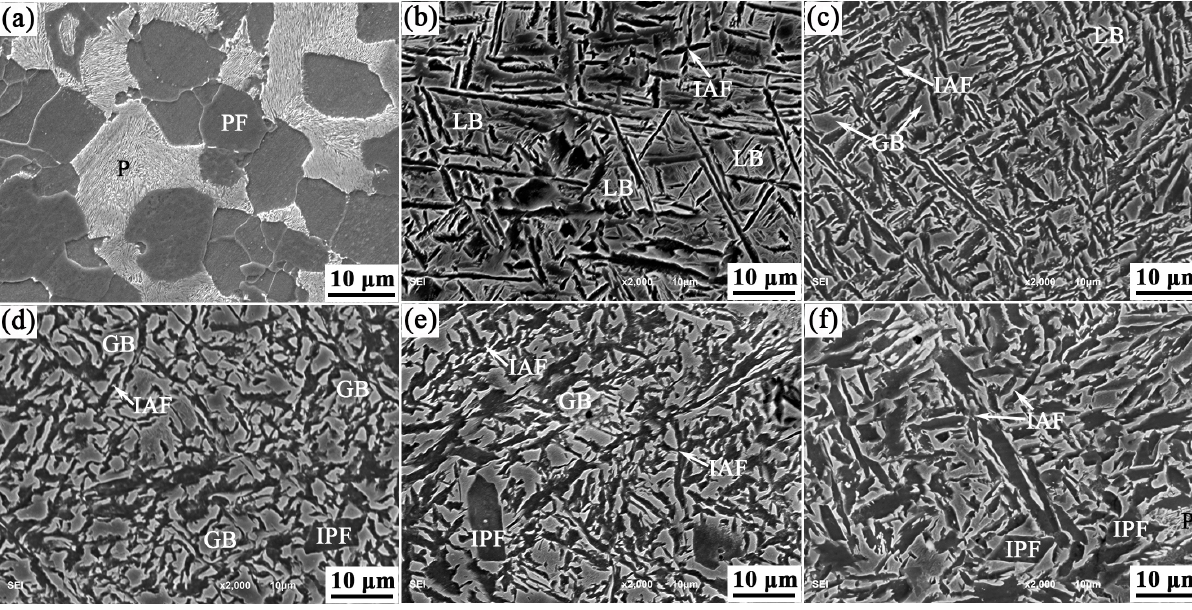
Figure 3: SEM micrographs of the BM and the simulated CGHAZ at different t 8/5 : (a) BM; (b) 30 s; (c) 60 s; (d) 90 s; (e) 120 s; (f) 180